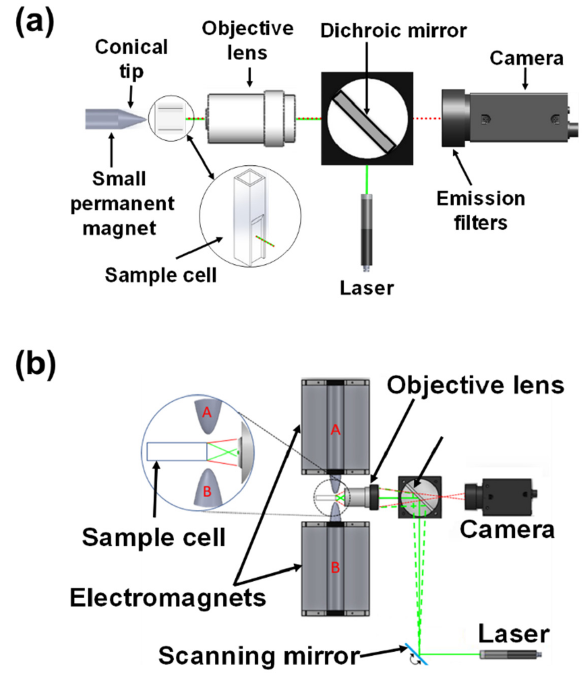
Figure 14. Schematic representations of ( a ) a magnetically aggregated biosensors (MAB) system, and ( b ) an optical modulation biosensing (OMB) system. Reprinted from [15], with the permission Reprinted from [15], with the permission of AIP Publishing 2019. ( b ) an optical modulation biosensing of AIP Publishing 2019. (OMB) system. Reprinted with permission from [61] © 2021 The Optical